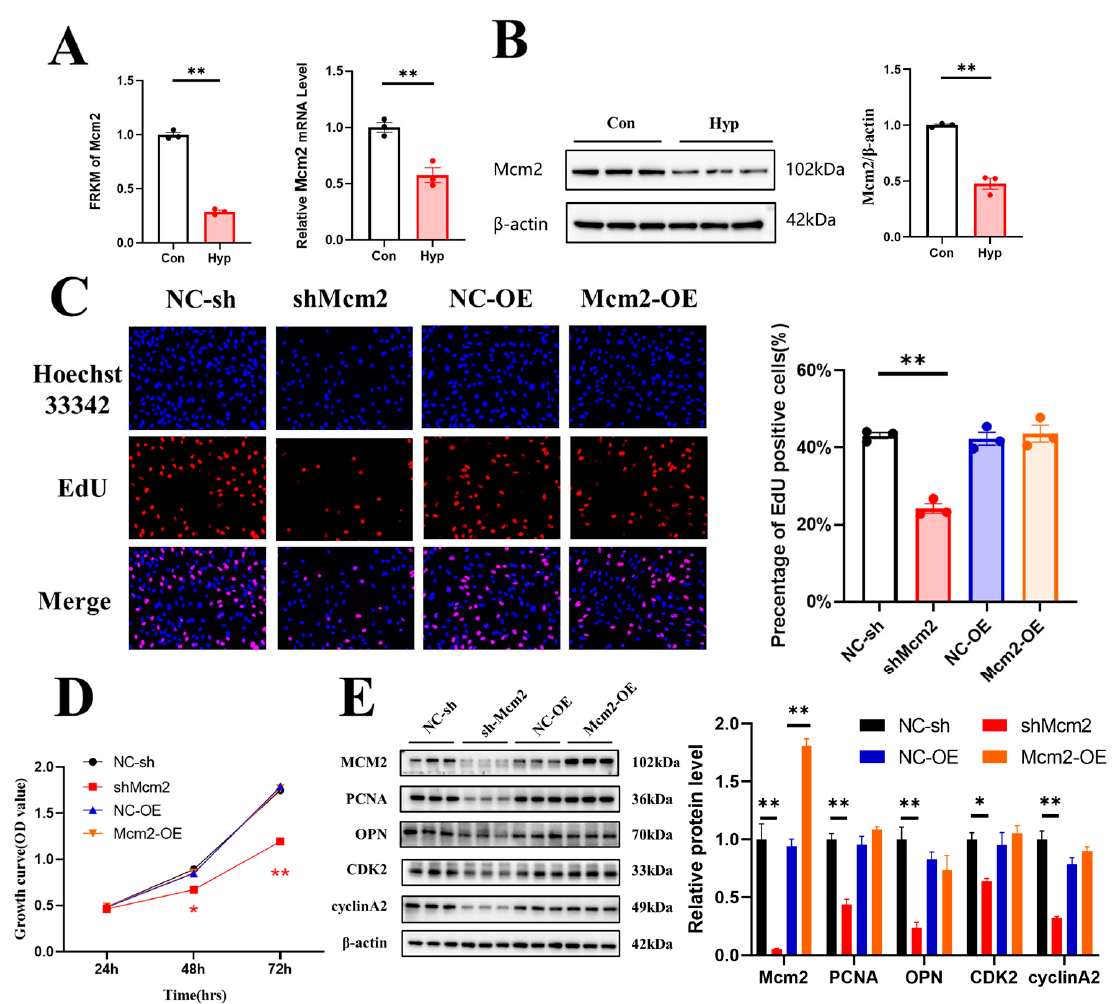
Figure 3. Knockdown of Minichromosome maintenance complex component 2 (Mcm2) inhibits cell cycle progression and cell proliferation. ( A ) The expression of Mcm2 from RNA-seq data and qRT–PCR ( n = 3). ( B ) MCM2 expression was determined by Western blotting ( n = 3). ( C ) The EdU (red) assay was used to examine cell proliferation ( n = 3). EVOS M5000 objective magnification: 20×. ( D ) Cell proliferation was evaluated by a CCK-8 assay ( n = 3). The symbol * (red) represents the shMcm2 vs. NC-sh group. ( E ) Western blot analysis of MCM2, PCNA, OPN, CDK2 and cyclin A2 ( n = 3). Data are shown as the mean ± SEM, * p < 0.05, ** p < 0.01. NC indicates negative control, and OE indicates overexpression.